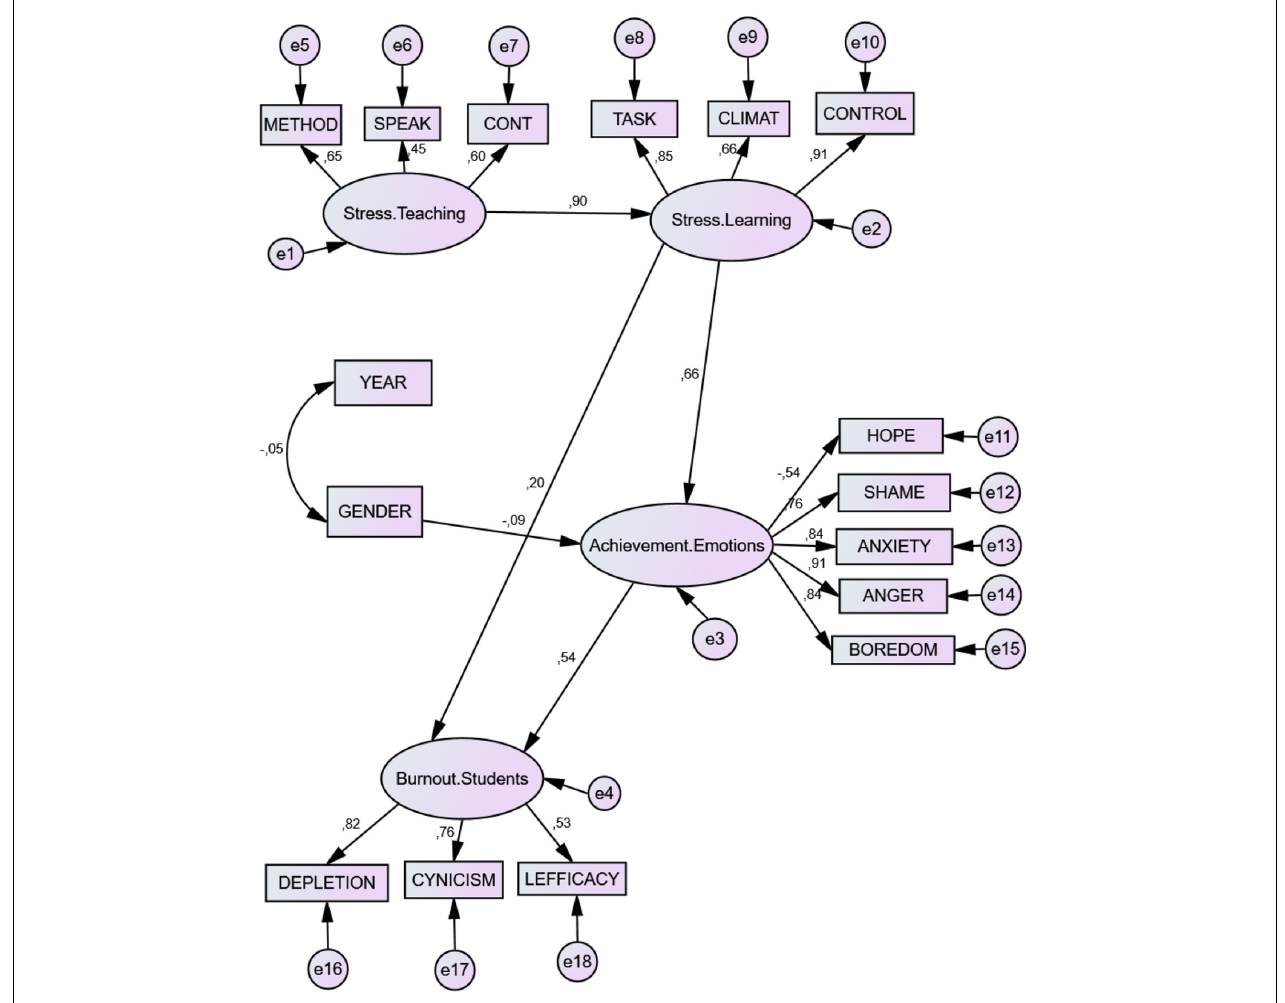
FIGURE 1 | Structural predictive model. Stress.Teaching = Stress Factors in Teaching process; Stress.Learning = Stress Factors in Learning process; Achievement.Emotions = achievement emotions during study; Burnout.Students = Burnout; METHOD = methodological difficulties; SPEAK = speaking in public; CONT = value of the content; TASK = heavy workload; CLIMAT = negative social climate; CONTROL = lack of control over achievement; HOPE = Hope.Study; ANXIETY = Anxiety.Study; ANGER = Anger.Study; SHAME = Shame.Study; BOREDOM = Boredom.Study; DEPLETION = Exhaustion; CYNICISM = cynicism; LEFFICACY = Lack of efficacy. Gender (1 = Men; 2 =